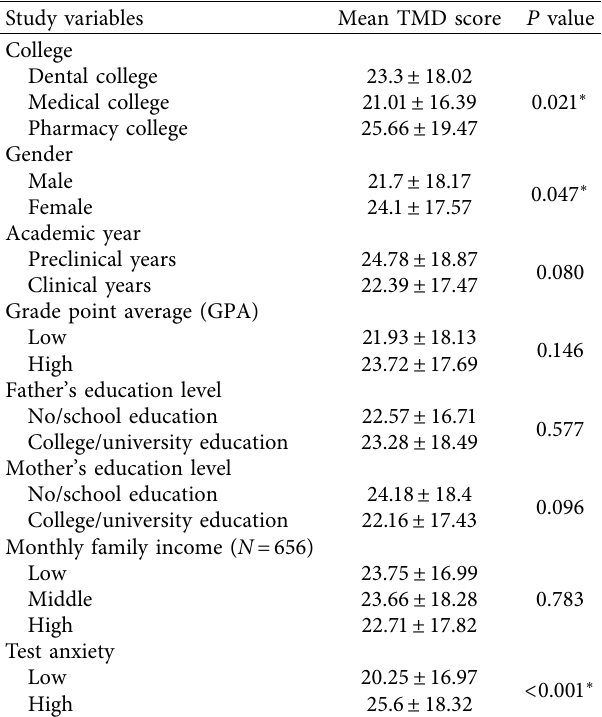
Table 3: Comparison of TMD score in different categories of study participants.